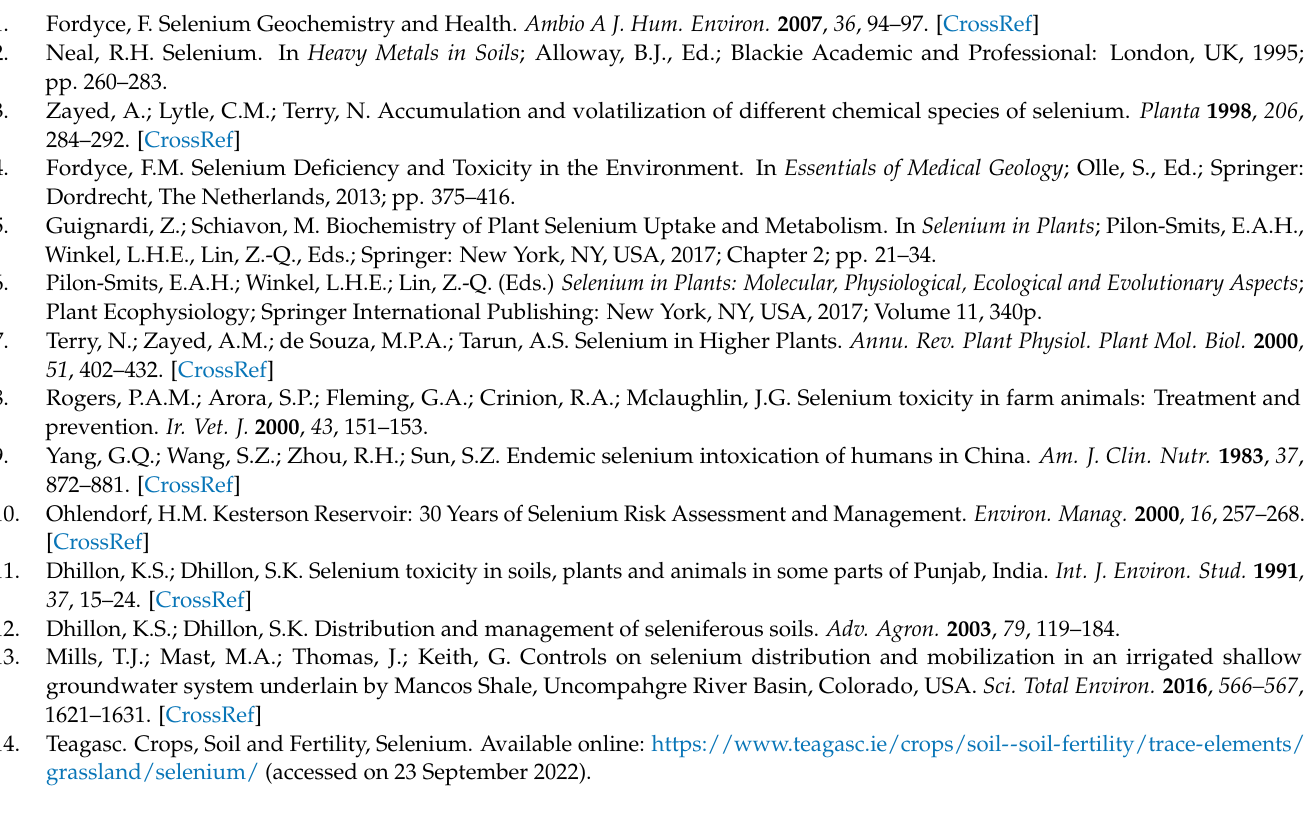
Figure A8. Photographs of the Se accumulator species Brassica oleracea (hispi cabbage, red cabbage ( left ) and premier kale ( right )). Note that the hispi cabbage has minor necrosis of the